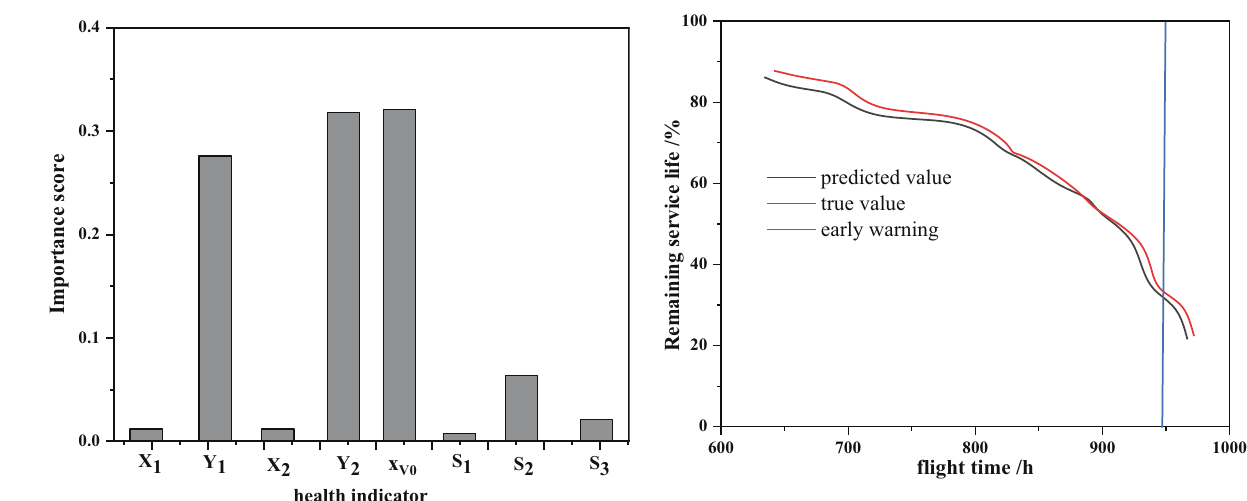
Figure 6: Comparison between predicted value and real value under internal